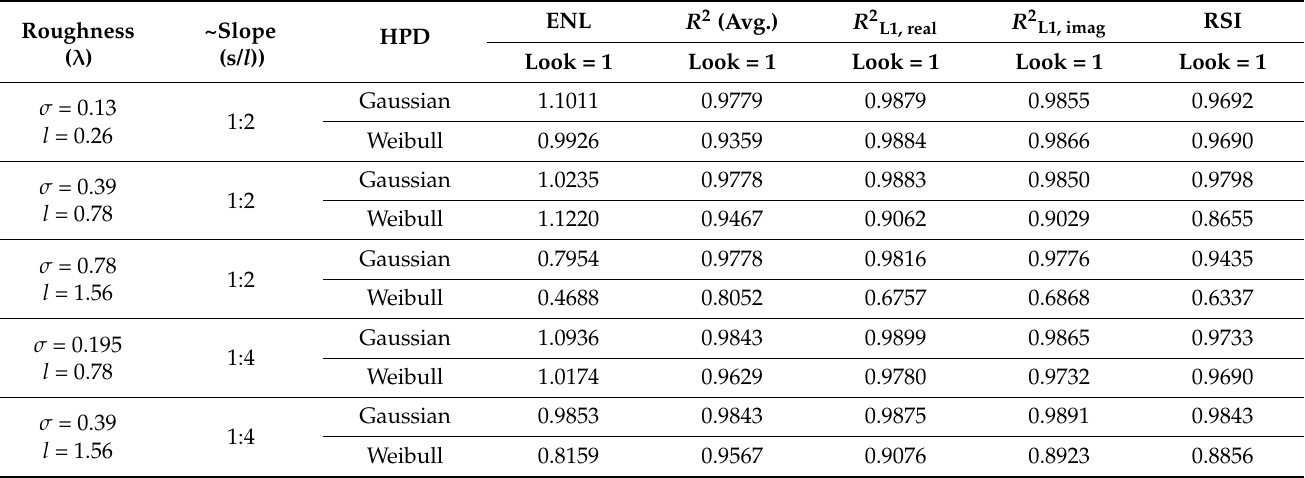
Table 6. Estimated ENL and R 2 coefficients under various roughness scale for Gaussian and Weibull HPDs